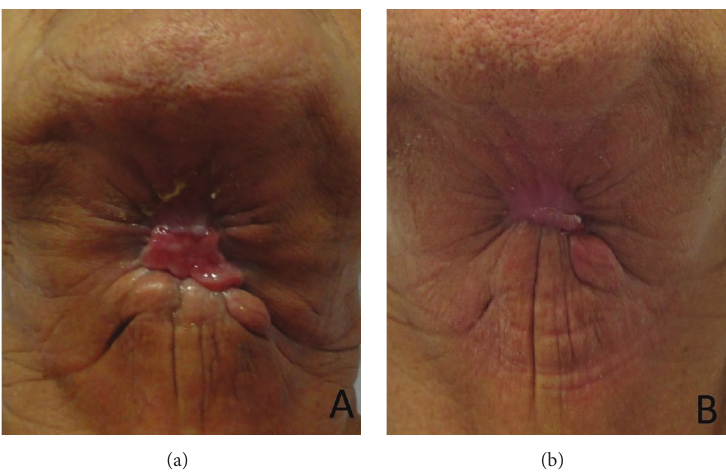
Figure 4: (a) After 30 days and (b) after seven weeks using silver alginate, a favorable healing was observed.